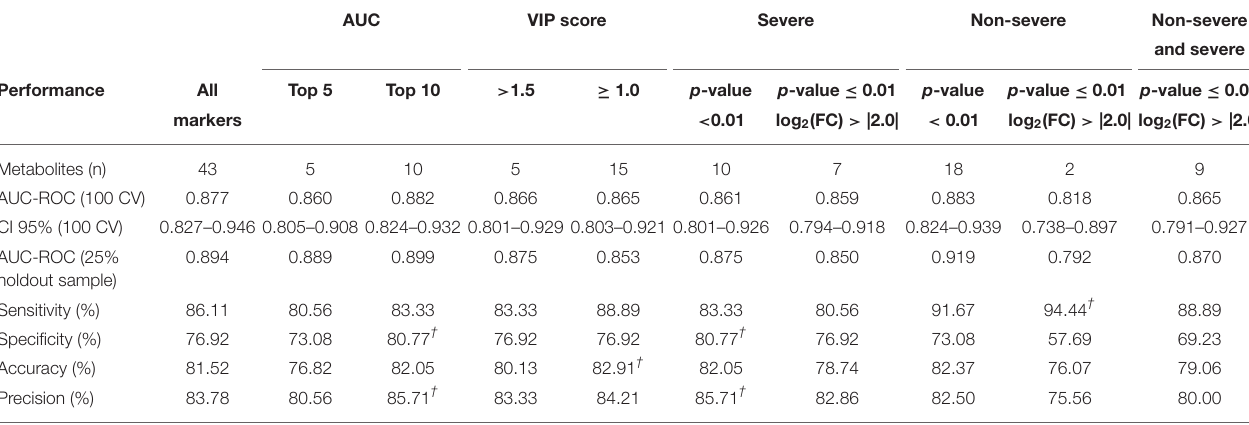
TABLE 4 | Summary of receiver operating characteristics (ROC) curve metrics discrimination of non-severe and severe COVID − 19 disease condition based on the metabolic profile. AUC VIP score Severe Non-severe Non-severe